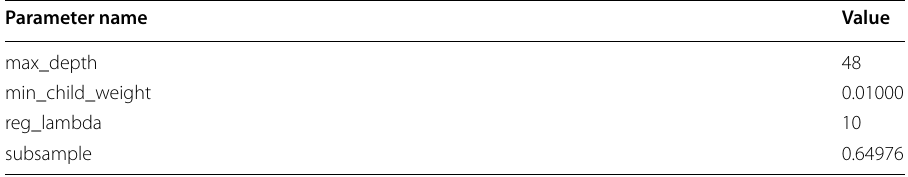
Table 79 Modes of XGBoost tuned hyperparameter values for experiments with the data exfiltration dataset